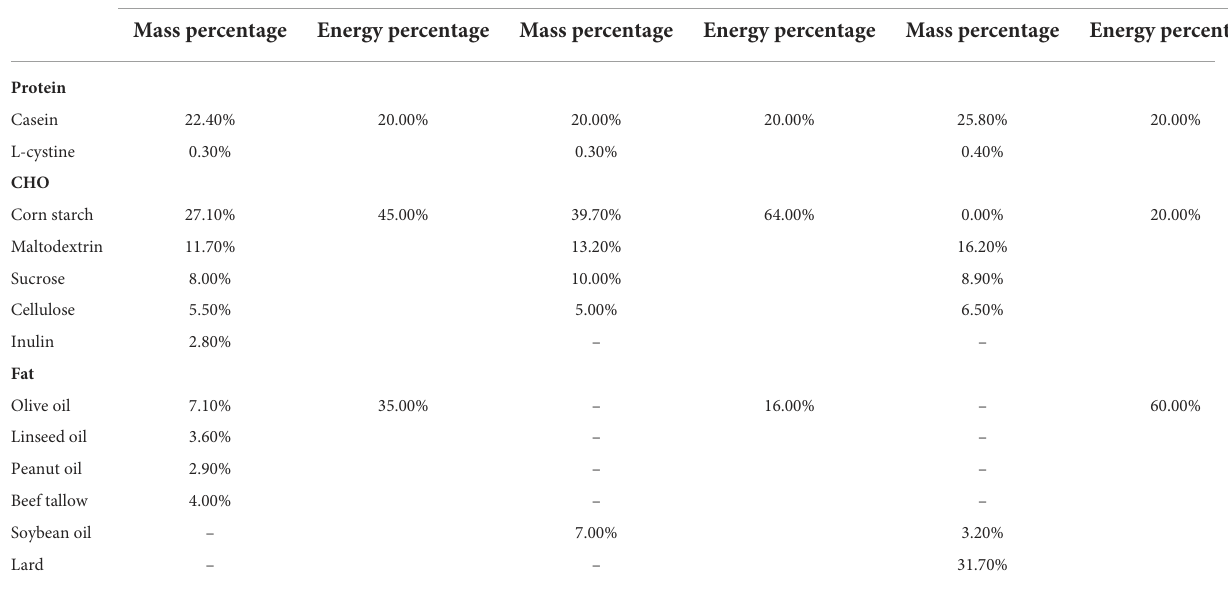
TABLE 1 Three mouse feed